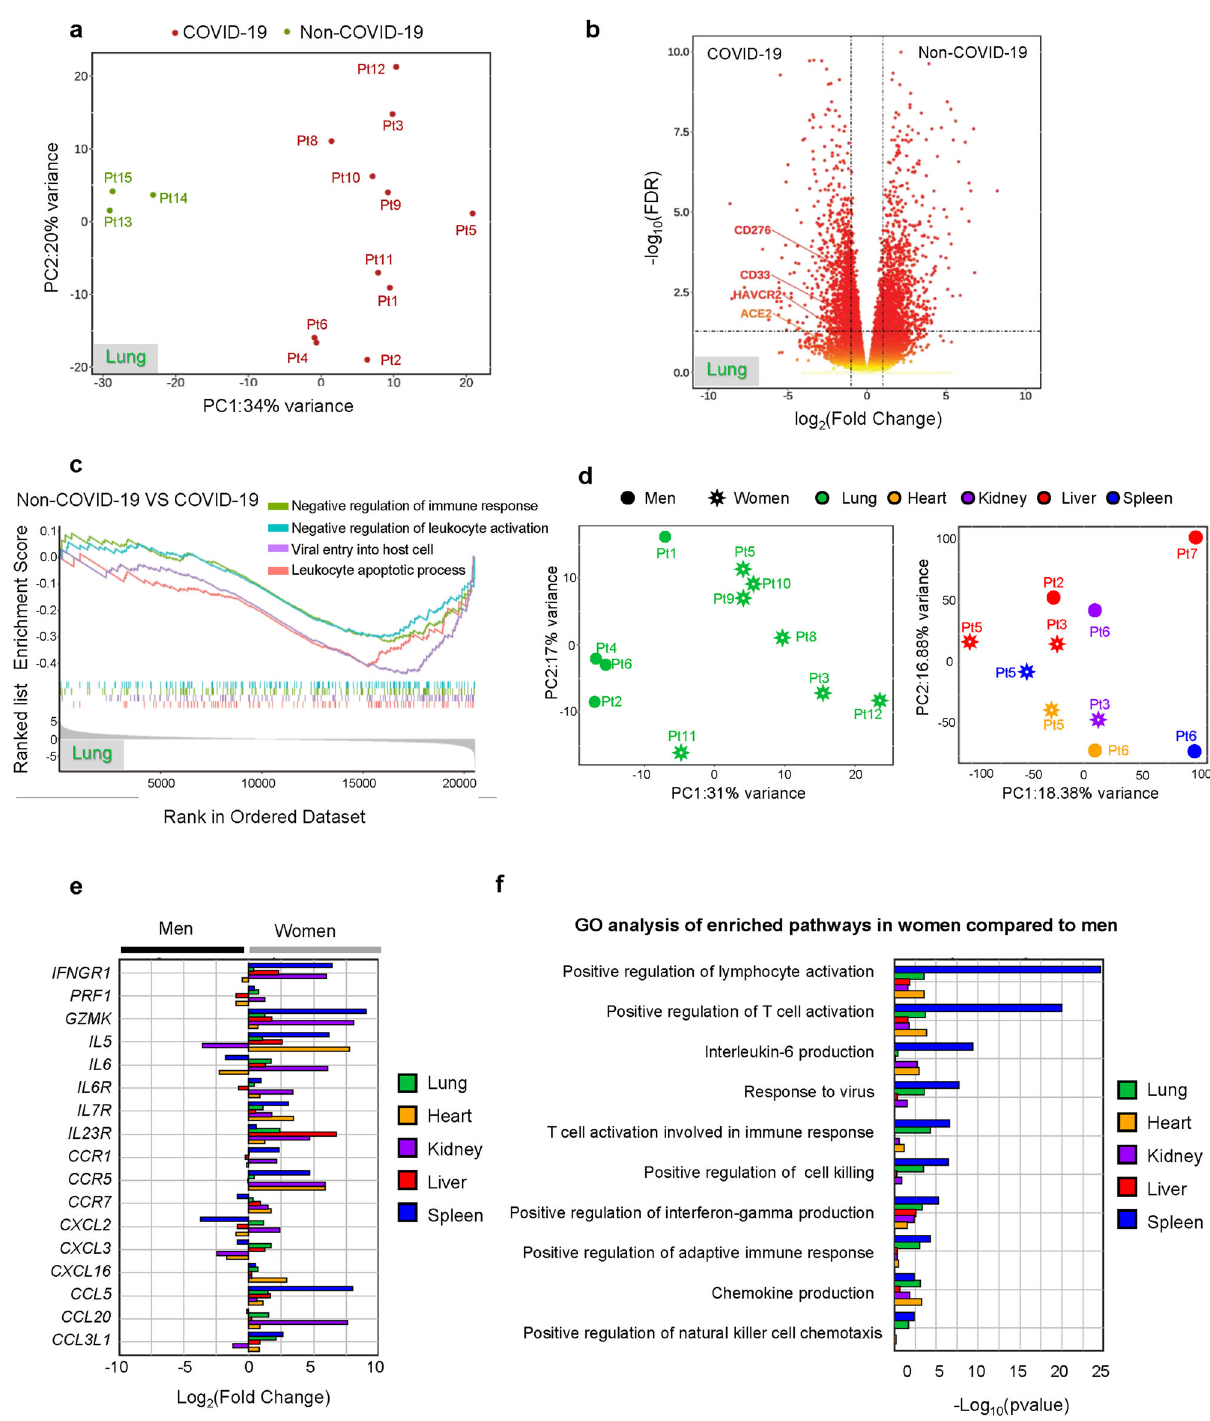
Fig. 1 Severe COVID-19 infection is characterized by immunosuppression and is more pronounced in men than women. a Principal component analysis of lung tissue of COVID-19 ( n = 11) compared to non-COVID-19 ( n = 3) decedents. Each dot corresponds to a single sample based on RNA ‐ seq data. b The differential genes expression between COVID-19 and non-COVID-19 of lung tissue, the vertical baseline represents the absolute value of log 2 fold change >1, and the horizontal baseline above represents p < 0.05. DESeq2 was used for differential gene expression analysis. c Gene set enrichment analysis of hallmark lymphocyte inhibitory genes based on non-COVID-19 to COVID-19. FDR < 0.05 de fi ned as signi fi cant. Gene sets are ranked by the difference in the fraction of experiments with signi fi cant positive and negative enrichment. d Principal component analysis of bulk transcriptomes of lung (green, women = 7, men = 4), heart (yellow, women = 1, men = 1), kidney (purple, women = 1, men = 1), liver (red, women = 2, men = 2) and spleen (blue, women = 1, men = 1). e Comparison chemokine expression levels between men and women in lung, heart, kidney, liver and spleen. Colored according to the sample based on RNA ‐ seq data. f Gene Ontology analysis of pathways enriched of multiple organs in women upregulate compared to men. Colored according to the sample based on RNA ‐ seq data. Fisher ’ s exact test. Source data are provided as a Source Data fi le.